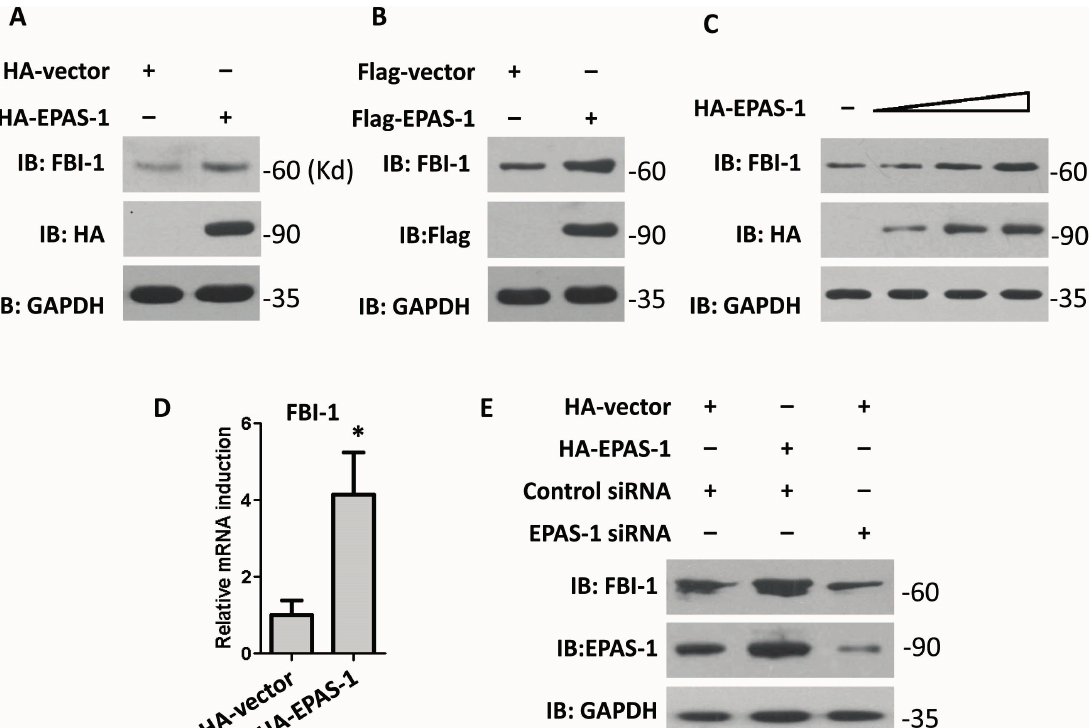
Figure 1. Endothelial pas domain protein-1 (EPAS-1) up-regulates the expression level of Factor binding IST-1 (FBI-1). ( A , B ) EPAS-1 over-expression up-regulated FBI-1 protein level. GAPDH were used as loading controls. Molecular sizes were marked in the right of each gel as Kd (same as follow); ( C ) EPAS-1 up-regulated FBI-1 protein level in a dose-dependent manner. GAPDH were used as loading controls; ( D ) EPAS-1 over-expression up-regulated FBI-1 mRNA level. Data points were determined in triplicate and shown with the mean ± SD (* p < 0.05, t -test); and ( E ) EPAS-1 knockdown reduced FBI-1 protein level. GAPDH were used as loading